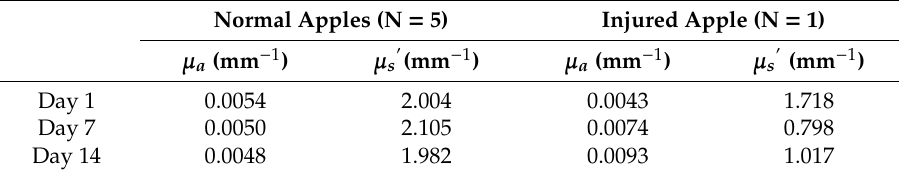
Figure 7. ( a ) Absorption and ( b ) reduced scattering coefficients of injured apples (red circles) and normal apples (black squares) recovered at a wavelength of 660 nm in 14 days. Table 1. Optical properties of normal apples and injured apple recovered at 660 nm in 14 days.